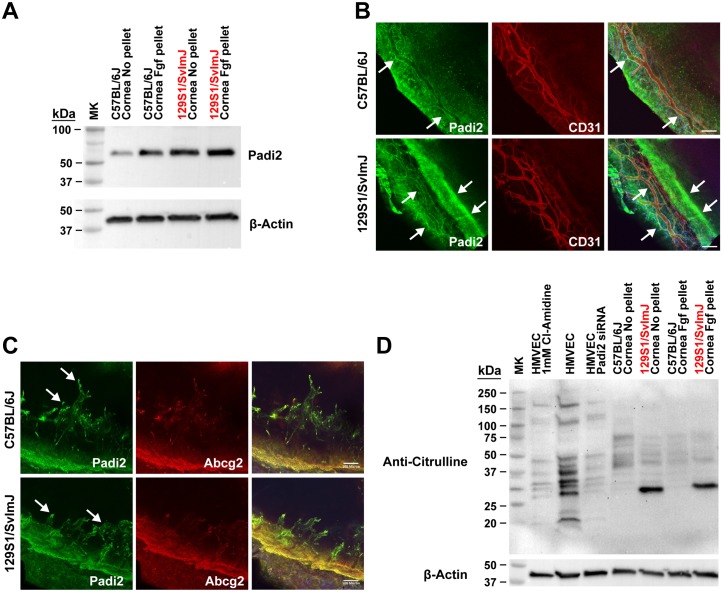
Padi2 expression level corresponds with the level of citrullinated protein in both unstimulated and bFGF stimulated corneas.A) Western blot of unstimulated cornea from C57BL/6J and 129S1/SvImJ verifying the RT-PCR experiments. B) Immunofluorescent staining of unstimulated corneas from C57BL/6J and 129S1/SvImJ. Quantification of Padi2 staining relative to cell number (S5 Fig) is higher, as visible from the green staining, at the limbal basal epithelial cells and limbal vasculatures of cornea from 129S1/SvImJ strain. C) Co-staining experiment for Abcg2 and Padi2 using confocal laser scanning microscopy of bFGF stimulated corneas from C57BL/6J and 129S1/SvImJ. Padi2 is clearly expressed in both Abcg2+ limbal basal cells and new bFGF-induced vessels. Scale bar = 100 μm. D) Knockdown of PADI2 and inhibition by Cl-Amidine treatment significantly reduces deiminated proteins in HMVECs. Significant difference in intrapeptide citrullination between the two strains. Anti-Citrulline antibody (Abcam, Cambridge, MA) used in this experiment does not react with free citrulline or arginine and reacts only with intrapeptidic citrulline regardless of the amino acid sequence. We further verified this by HPLC (S5 Fig).